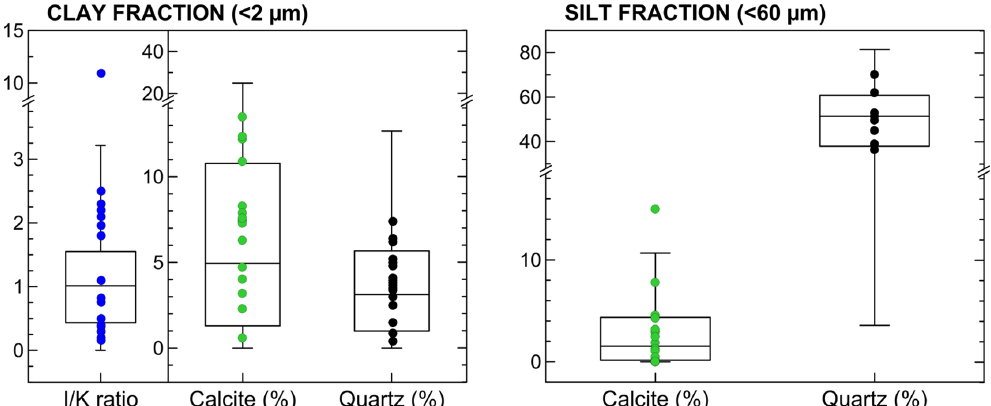
Figure 3. Box and whisker plots showing the variability of the soil composition in the clay and silt fractions at the global scale, i.e., by considering all data from the nine dust source areas identified in Fig. 2. Data are from the soil mineralogical database by Journet et al. (2014). Dots indicate specific mineralogical characteristics (illite-to-kaolinite mass ratio (I / K), calcite and quartz contents, extracted from Journet et al., 2014) of the soils used in the CESAM experiments, as listed in Table 2.